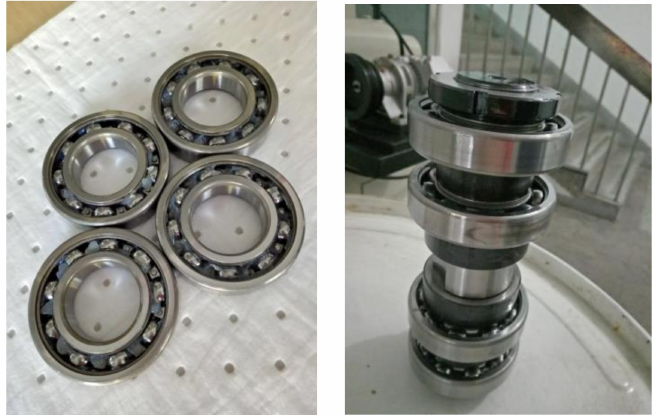
Figure 9. The assembled test bearing test